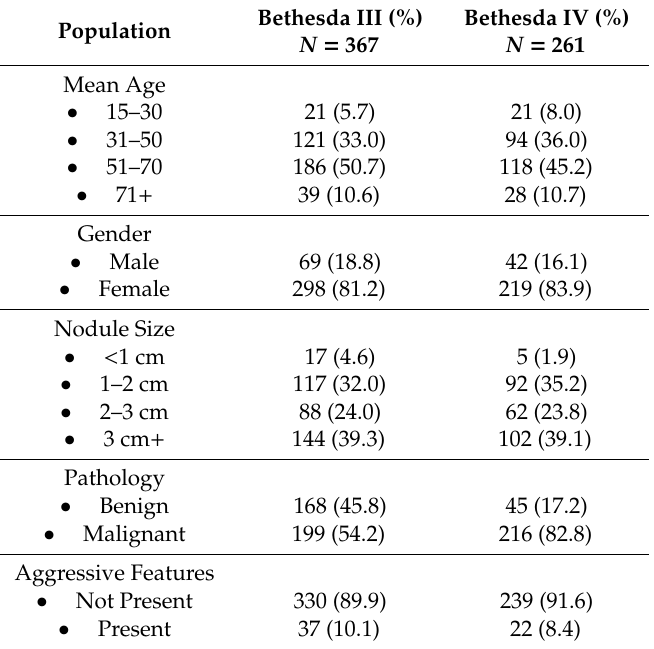
Table 1. Baseline